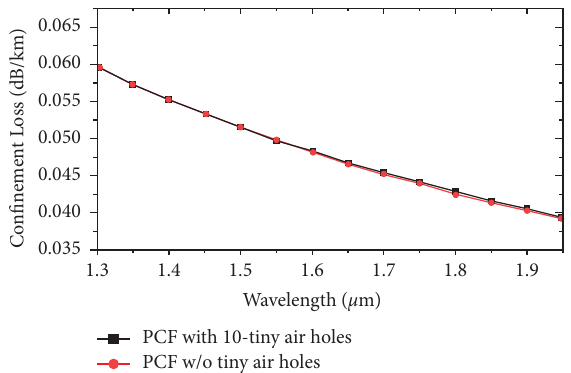
Figure 9: Confnement loss as a function of wavelength, λ for diferent structures of PCF (a) and PCF (b) at a constant air hole � 1.5 µ m and a pitch of Λ � 2.2 µ m. size of d 0